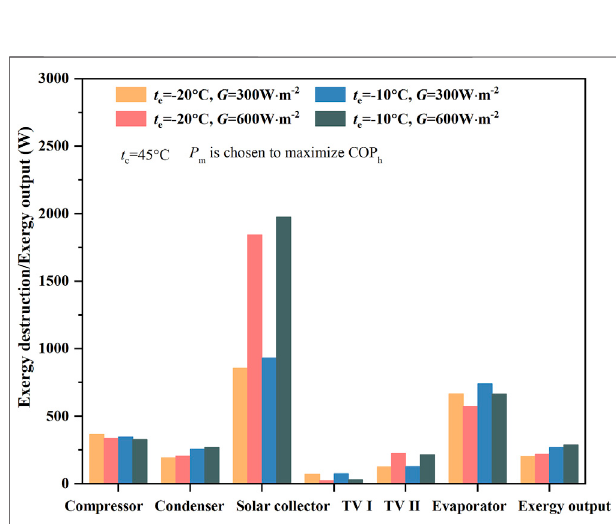
FIGURE 9 | Component exergy destructions under different solar radiation